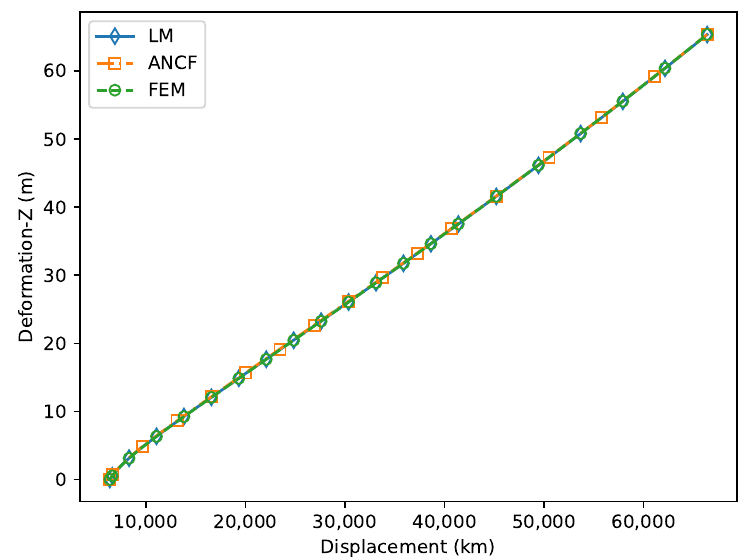
Figure 11. Deformation Z results of three